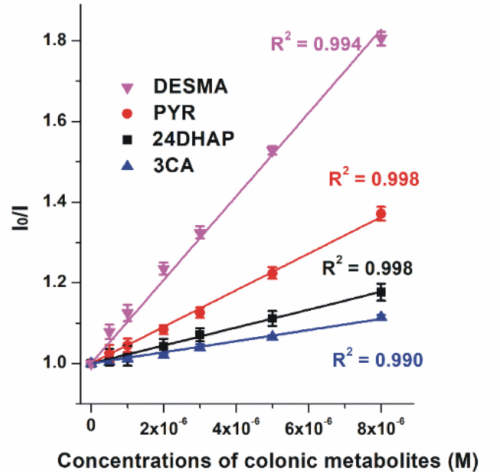
Figure 3. Stern-Volmer plots of metabolite-HSA complexes ( λ ex = 295nm, λ em = 340nm). Means and SEM values are derived from three independent experiments (DESMA, O -desmethylangolensin; PYR, pyrogallol; 24DHAP, 2,4-dihydroxyacetophenon; 3CA, 3-coumaric